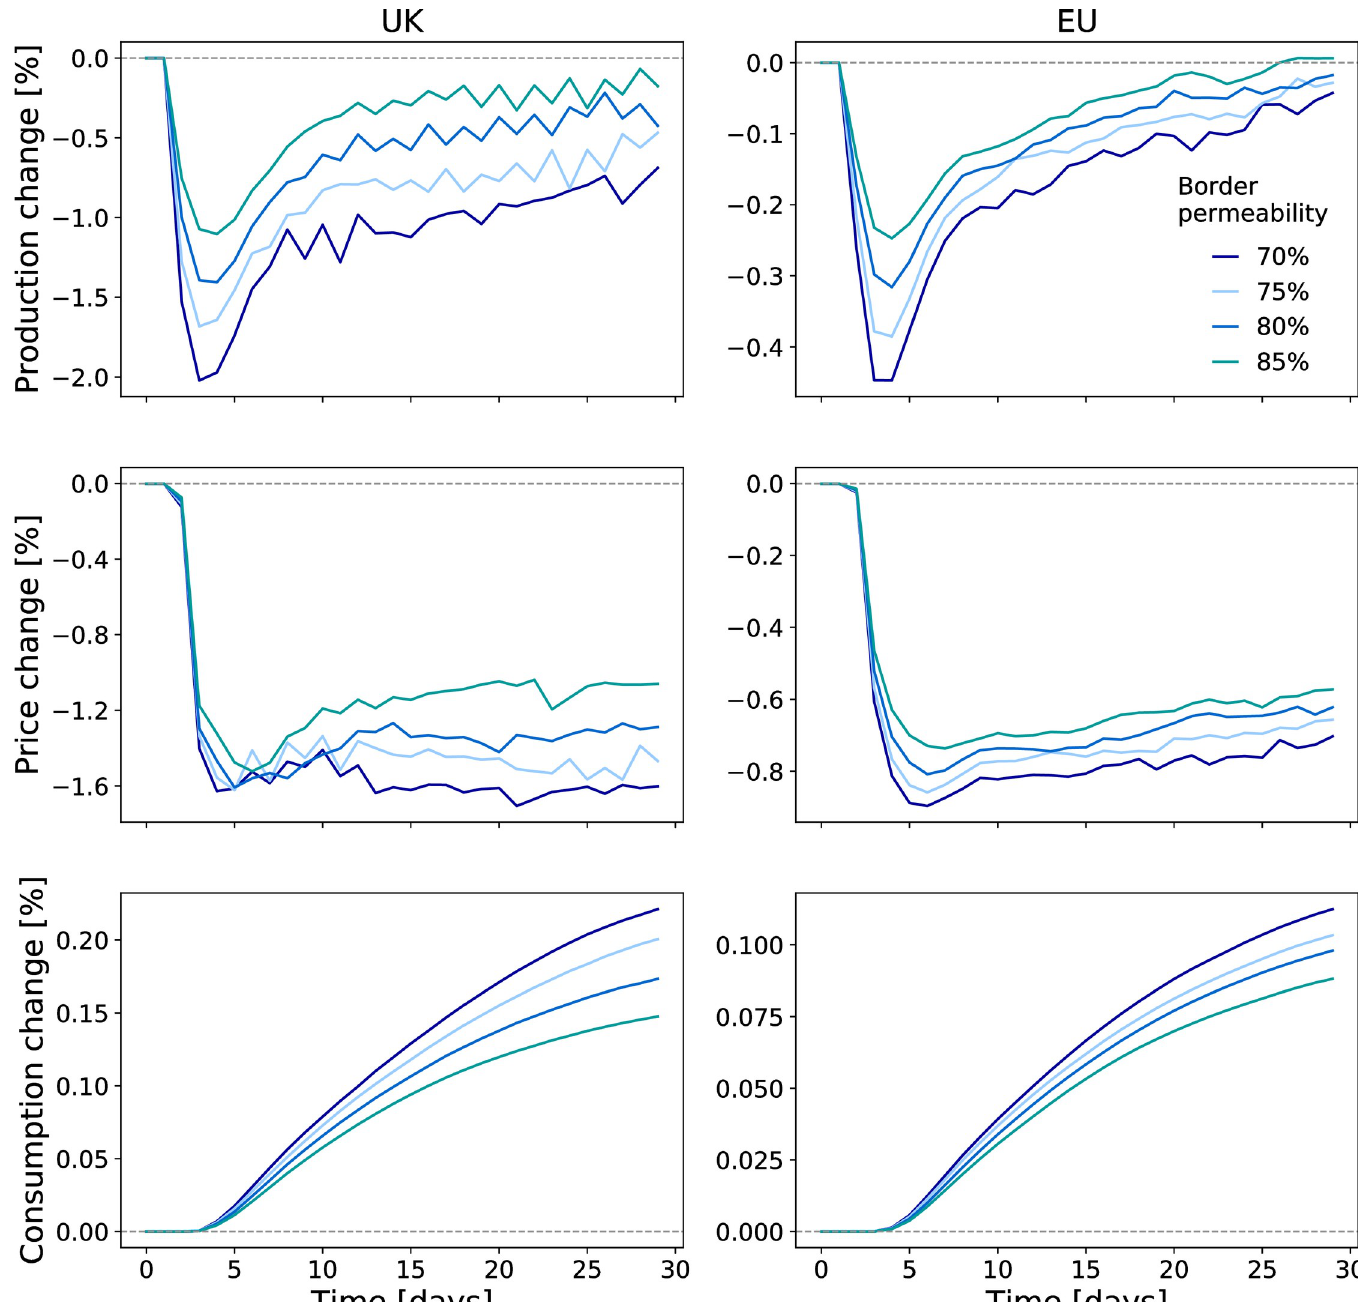
Fig 2. Changes in production, prices and consumption in the UK and the EU during the 30 days following a no-trade-deal event. The number of goods being produced declines in both, the UK and the EU shortly after a no-trade-deal event (first row) because customers on the respective other side of the UK-EU border demand less. Consequently, firms reduce production prices (second row). These lower prices stimulate demand for products slightly. Consumers respond to lower prices; consumption (quantities) rise (third row). In terms of value, i.e. the product of prices and quantities, production and consumption however remain below pre-Brexit levels throughout the simulation period (shown in S1 Fig in S1 File). All changes are depicted as relative deviation from the respective baseline values. Different scenarios of border permeability show similar dynamics. Reduced border permeability is assumed throughout the simulation period.